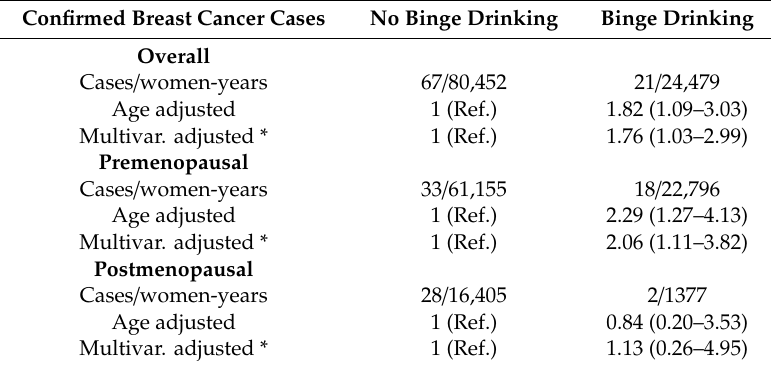
Table 2. Hazard ratio (95% CI) of overall breast cancer—confirmed cases—and by menopausal status according to binge drinking